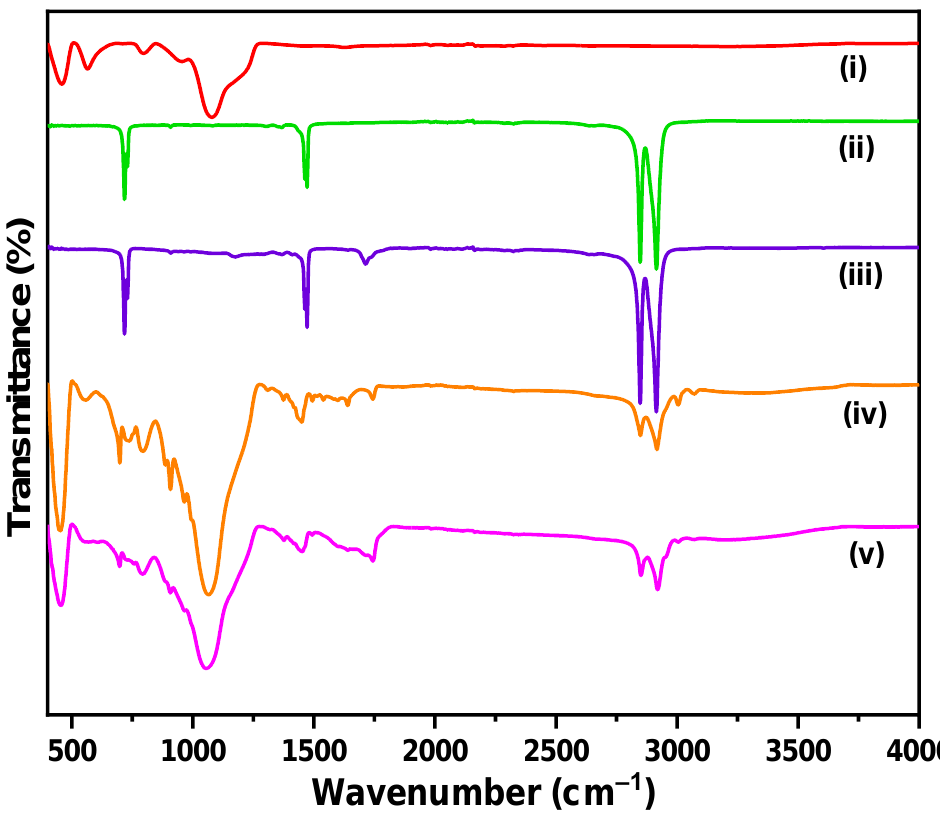
Figure 1. FTIR spectra of (i) Fe@SiO 2 /MDOS (ii) PE (iii) weathered PE 1000h (iv) TWP and (v) weathered TWP 1000h .